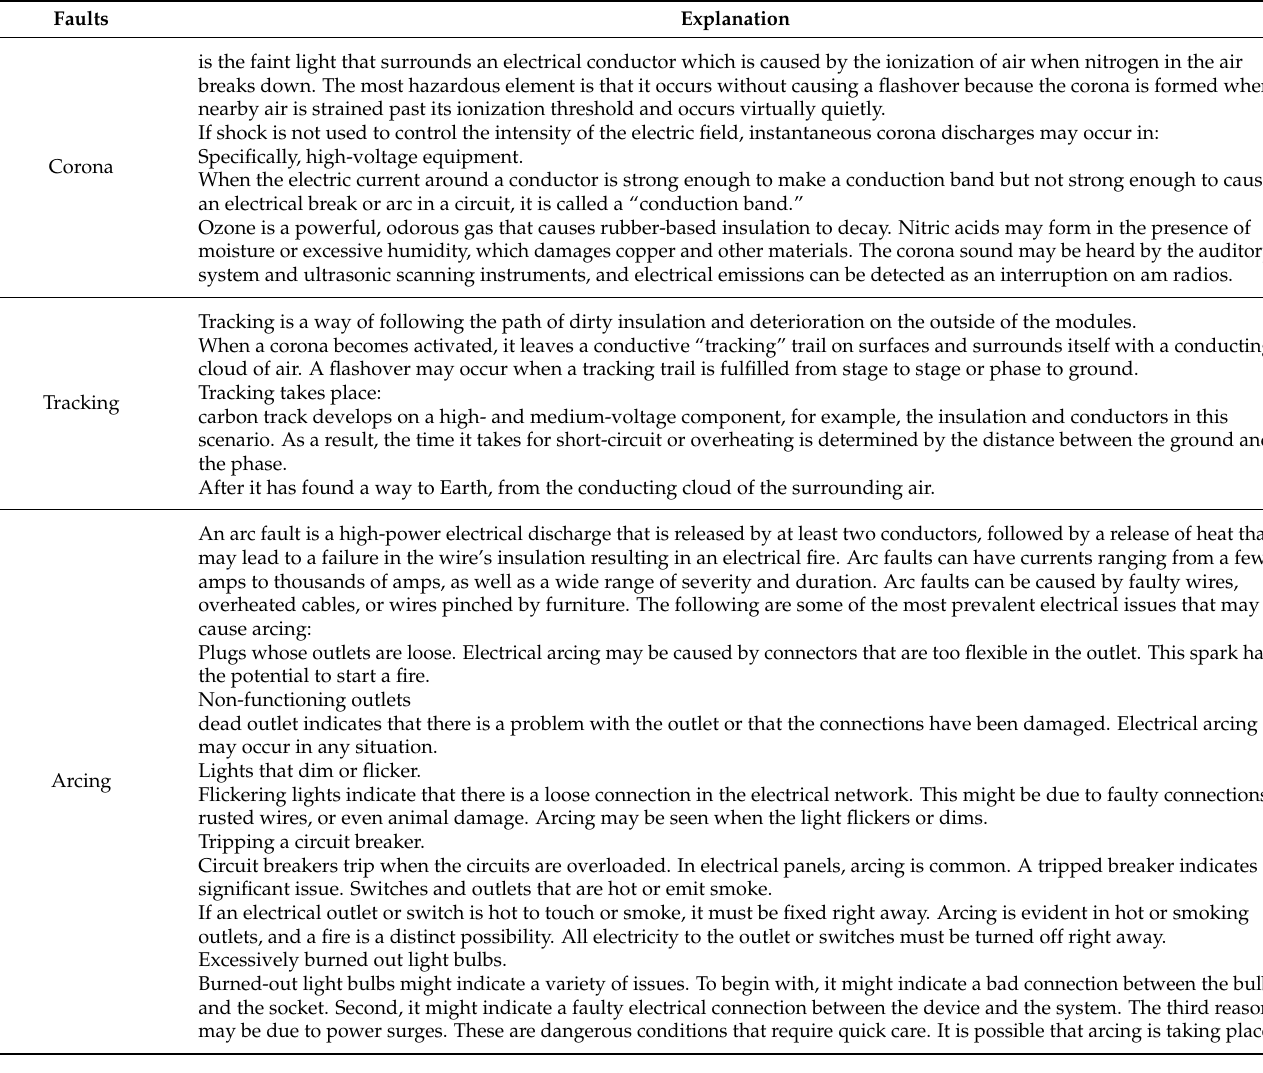
Table 3. Summary of faults on the switchgear.